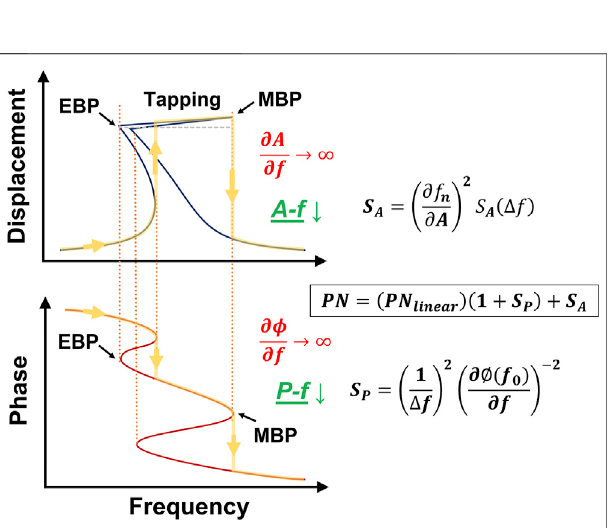
FIGURE 8 | Illustration of bifurcation points on the phase noise performance of vibro-impact resonators. Reproduced from Tsai et al. (2020b) with permission from IEEE.